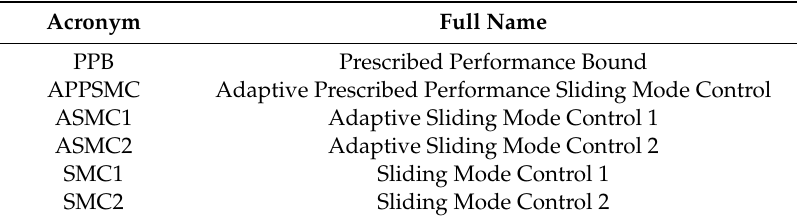
Table 2. Table of acronyms.